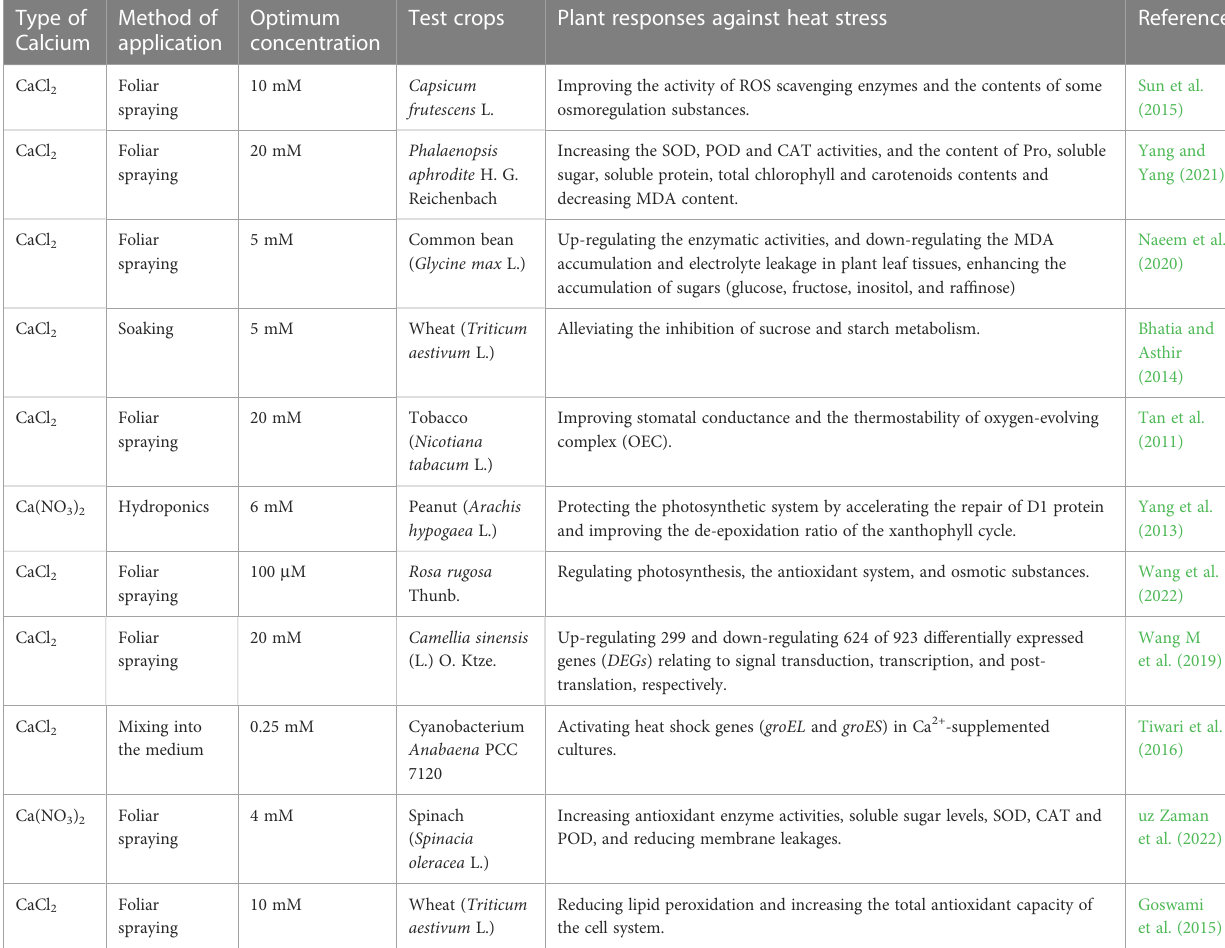
TABLE 4 List of optimal concentrations of exogenous calcium used to alleviate heat stress in different